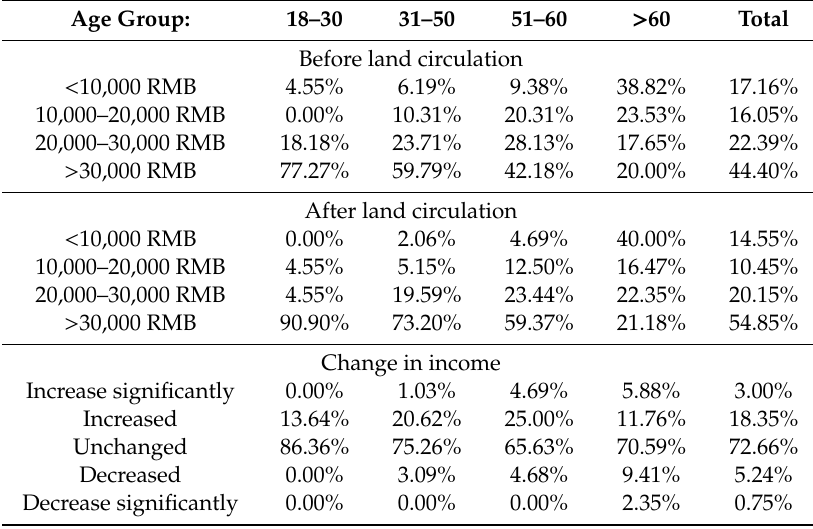
Table 3. Household income